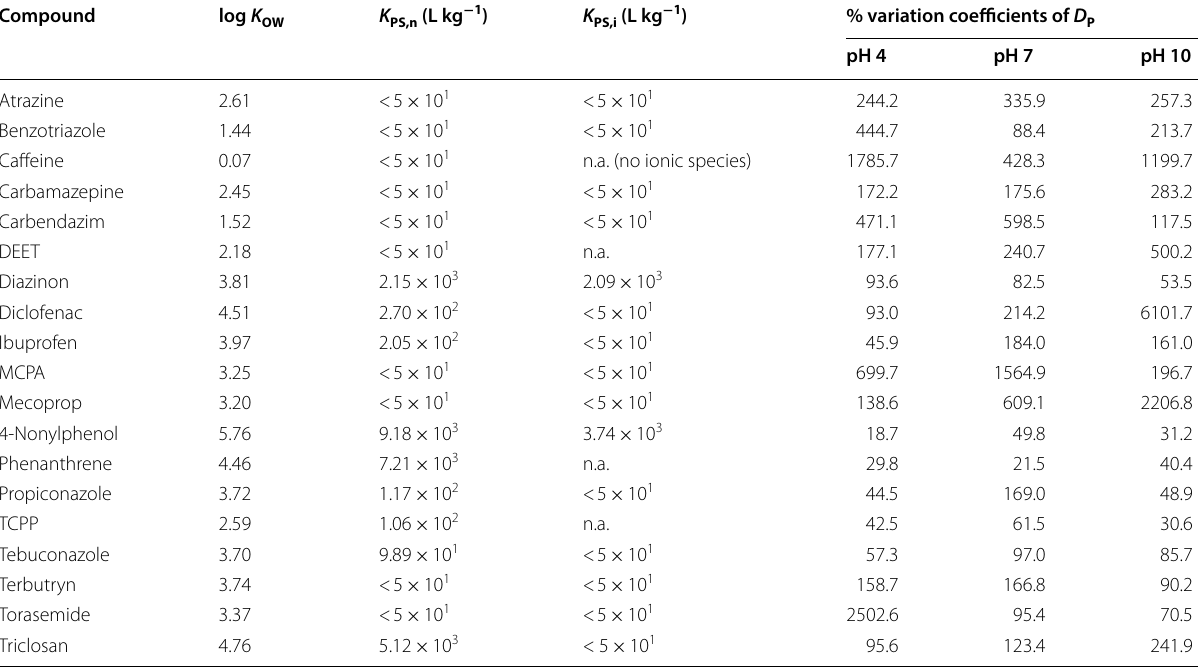
Table 3 K and K values derived from the model fit (Eq. 2) to measured D PS,n PS,i